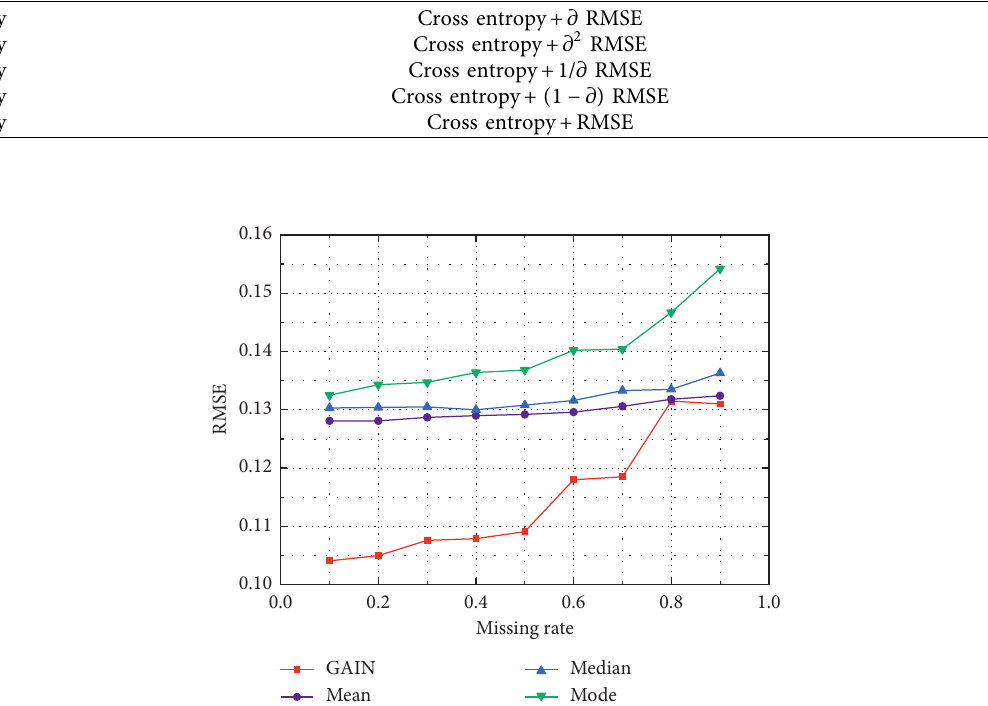
Figure 6: The results of different imputation methods for different missing data rates.